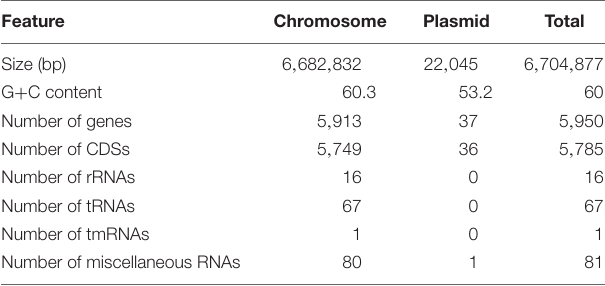
TABLE 1 | Genome statistics for Pseudomonas sp. 11K1.